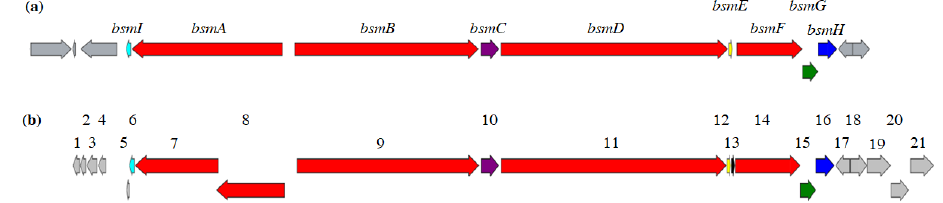
Figure 4. Alignment of the bosamycin ( bsm ) cluster ( a ) and the depsibosamycin ( dbm ) cluster ( b ) revealed 99.2% similarity.